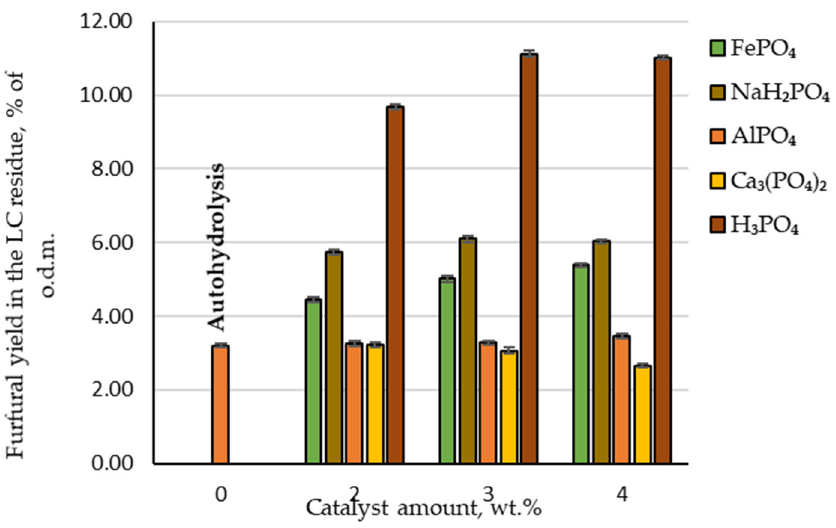
Figure 3. Furfural yields in the lignocellulose residue depending on the catalyst amount. A different situation can be observed when phosphorus-containing salts are used as catalysts to produce furfural (Figure 3). For example, furfural yield during hydrolysis almost did not change at any amount of AlPO 4 tested—21.3% of the t.p.y. (or 3.3% of the